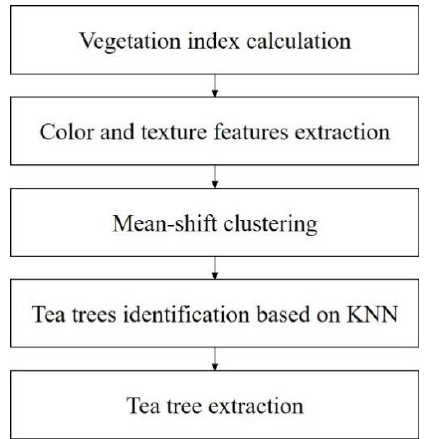
Figure 5. Flowchart of tea tree extraction.